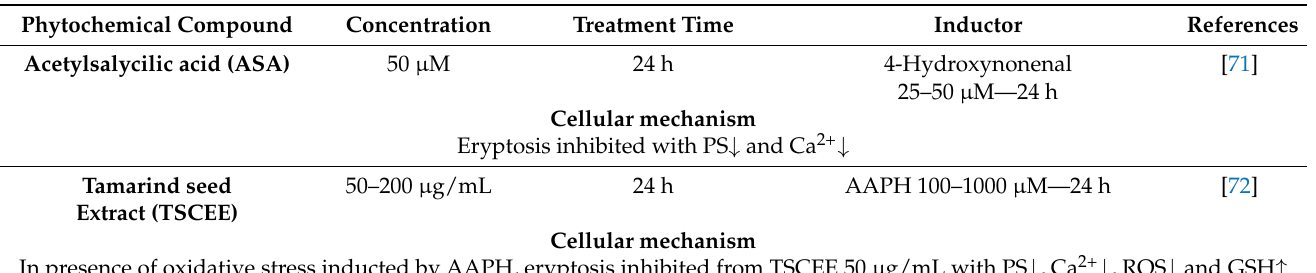
Table 3. Mechanisms involved in the anti-eryptotic effect of other natural compounds against different stimuli in human and rabbit